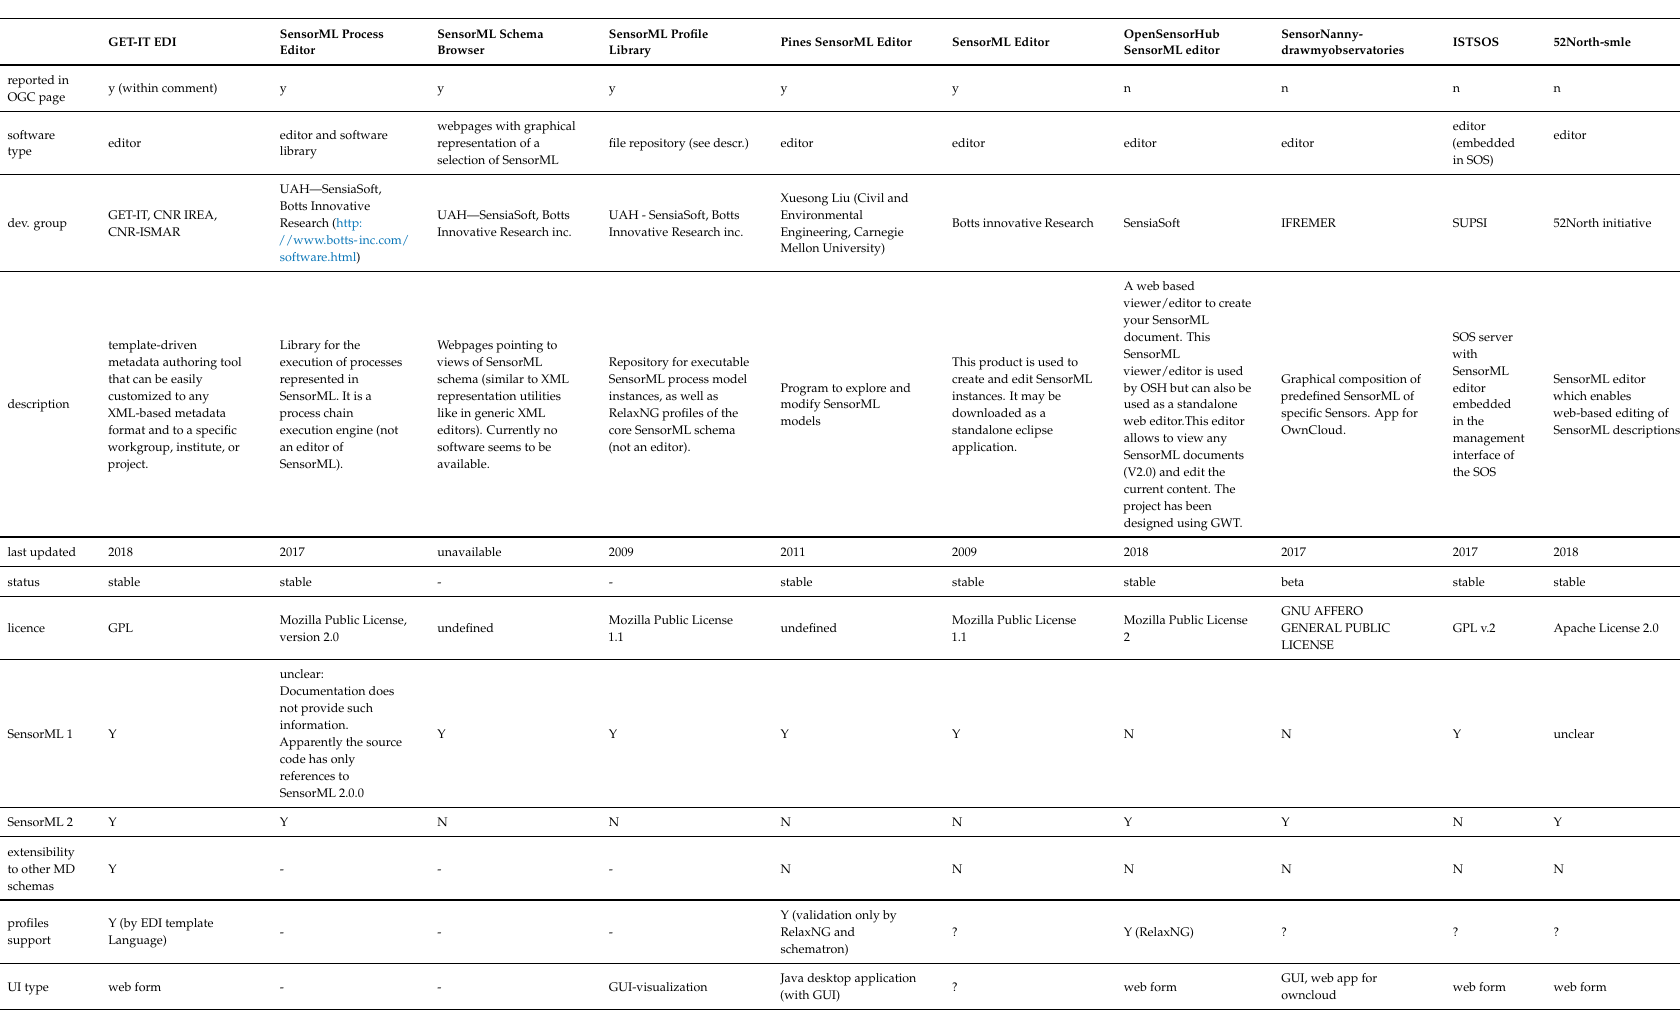
Table A1. SensorML editors: tentative enumeration and comparison of available software characteristics. Legend: “-” = non applicable; “?” = not enough information within documentation or other sources (code, examples, executable if